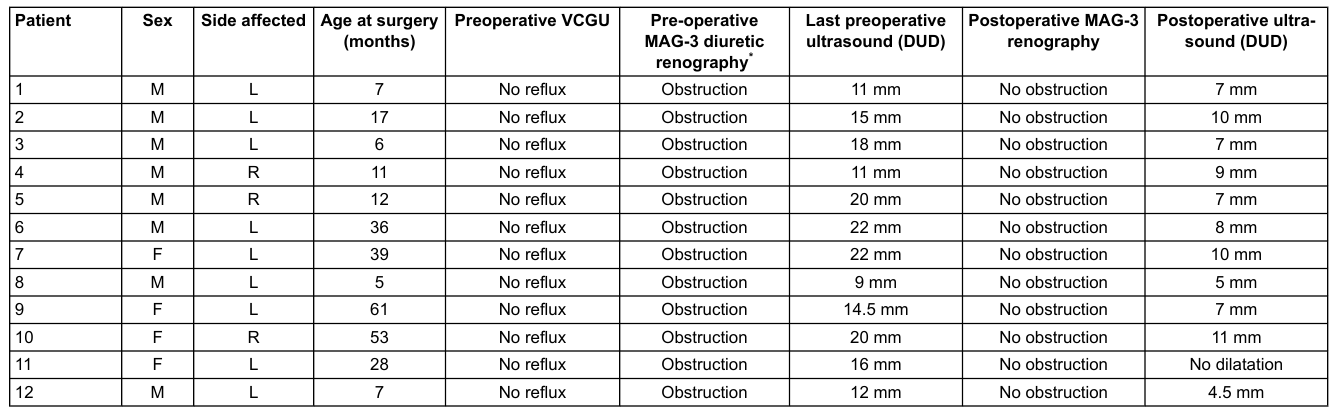
Table 2: Characteristics and outcomes of the